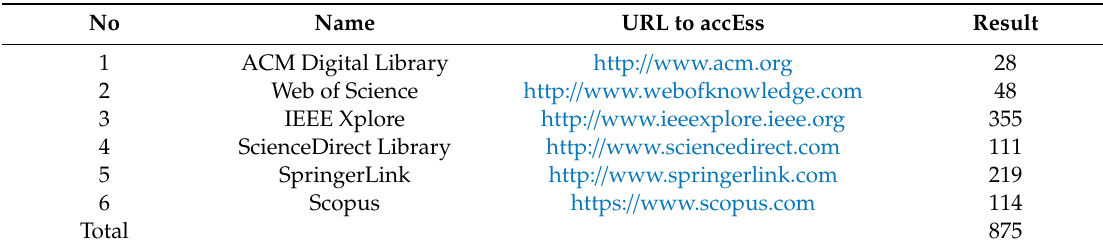
Table 2. Search Strings, Data Sources and Studies Identified.